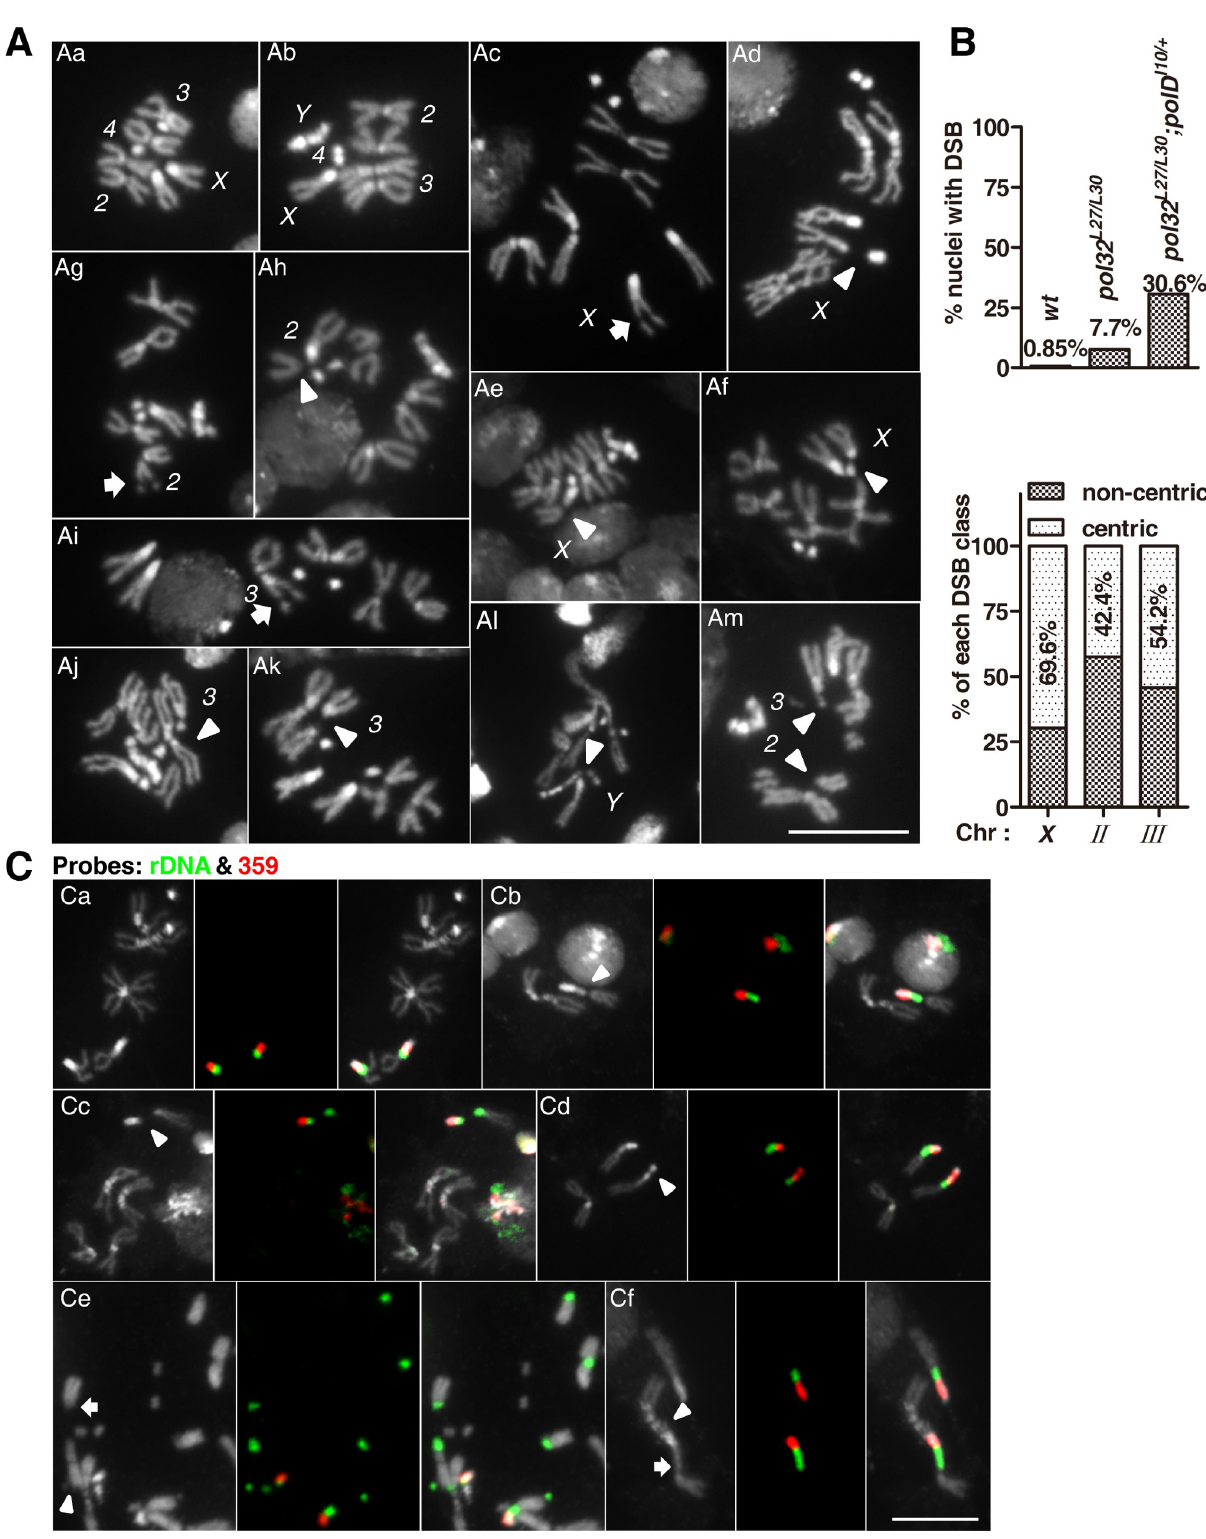
Fig 7. Loss of Pol32 induces chromosome breaks in post-embryonic cells. A . Mitotic figures showing the different classes of DSBs in the mutant pol32 L27/L30 ; polD l10/+ . In the two wild-type nuclei chromosomes are individually identified. In the mutant nuclei, only the chromosome with a DSB of